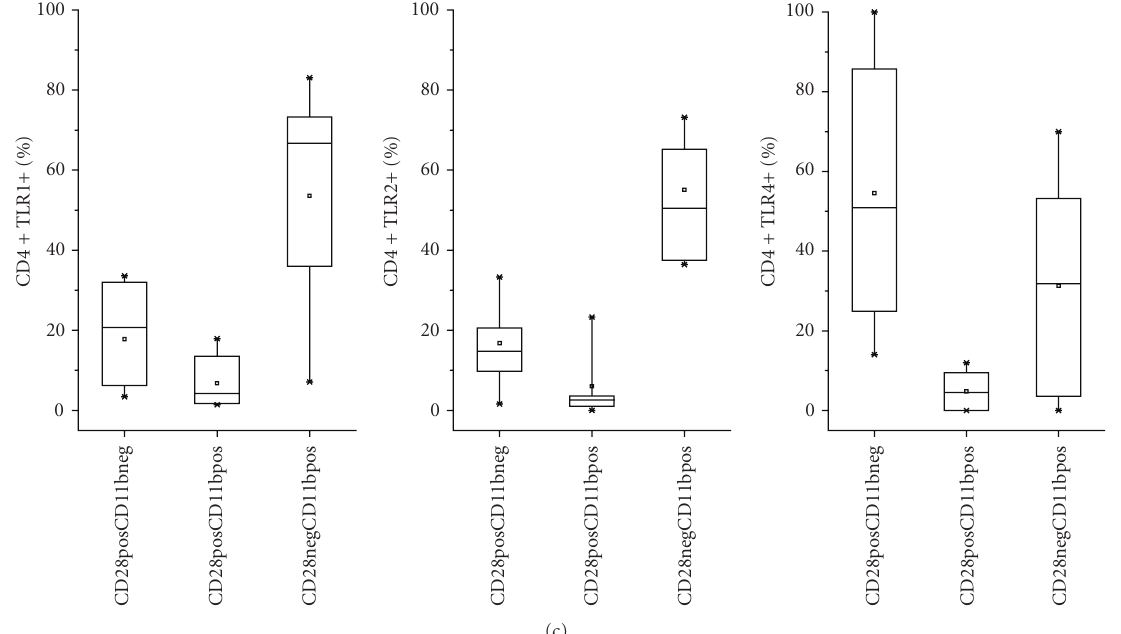
Figure 2: Expression of TLR on peripheral CD4+ T cells in patients with implant-associated osteomyelitis and healthy donors: (a) by cytofluorometry, expression of TLR1, TLR2, and TLR4 on CD4+ cells was determined. Each dot represents a patient or a donor, respectively. The horizontal bars represent the mean values. These were di ff erent between patients and donors as calculated by ANOVA. (b) When the gate (P2) was set for CD4+ cells, TLR positive cells could be identified (P3) (middle panel) and the expression of CD28 and CD11b on these cells could be determined (right panel). Four cell populations became apparent CD28-CD11b+ (Q1), CD28+CD11b+ (Q2), CD28-CD11b- (Q3), and CD28+CD11b- (Q4). The markers to determine positive or negative were set according to the isotype controls (not shown). The numbers refer to the percentage of cells in the respective quadrant and are calculated as per cent of TLR positive cells. In (b) an example for a single patient is shown, in (c) data of 10 patients and 9 donors are summarised in box and whiskers plots, with the horizontal bar showing the median, and the dot showing the mean values. (Again, markers to defines positive or negative were set according to the appropriate isotype